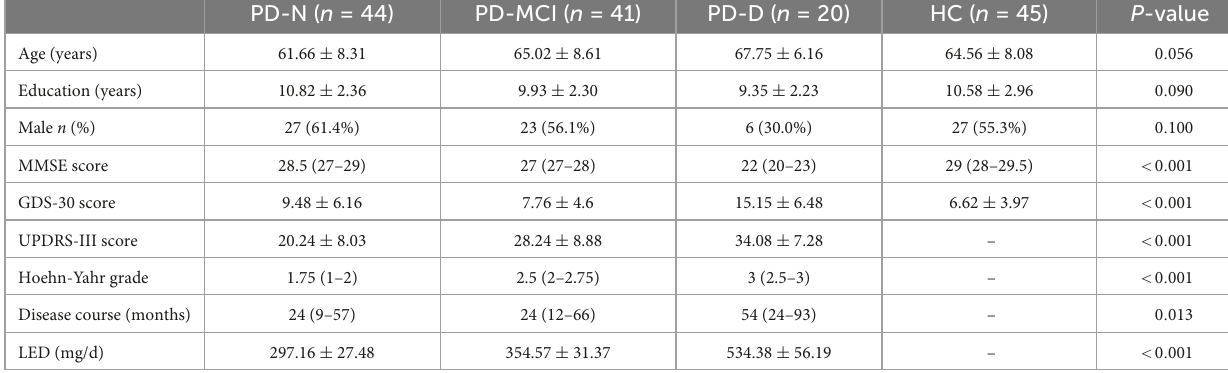
TABLE 1 Comparison of the general demographic data between the PD and HC groups.